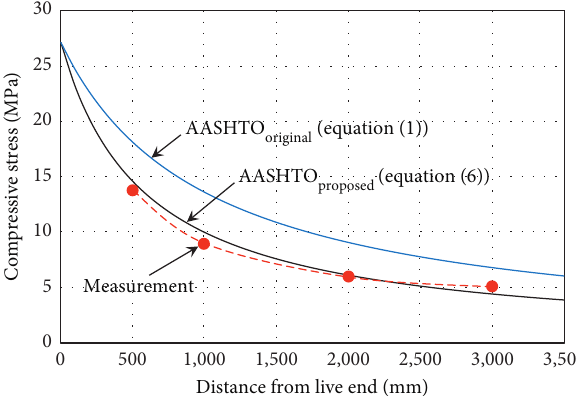
Figure 14: Comparison of longitudinal compressive stresses.